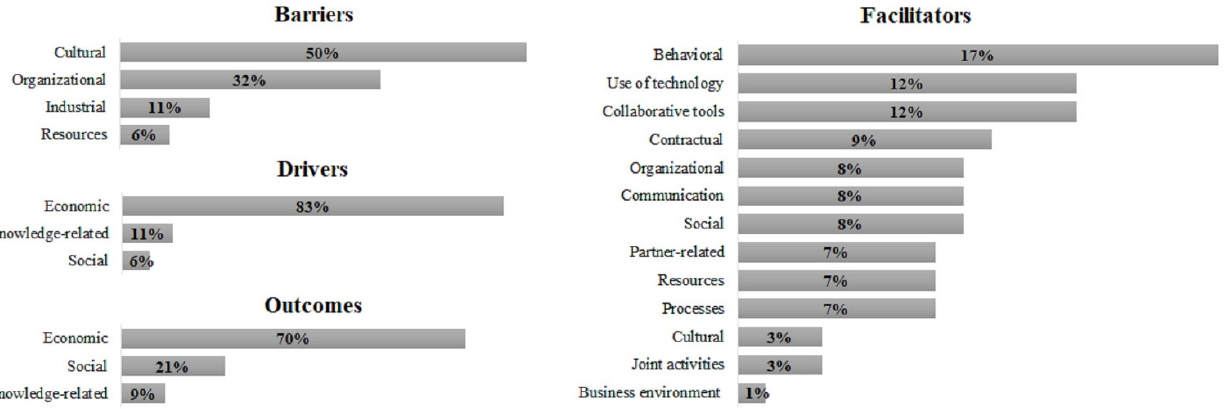
Figure 4. Frequency of citations of drivers, barriers, facilitators, and outcomes per category.